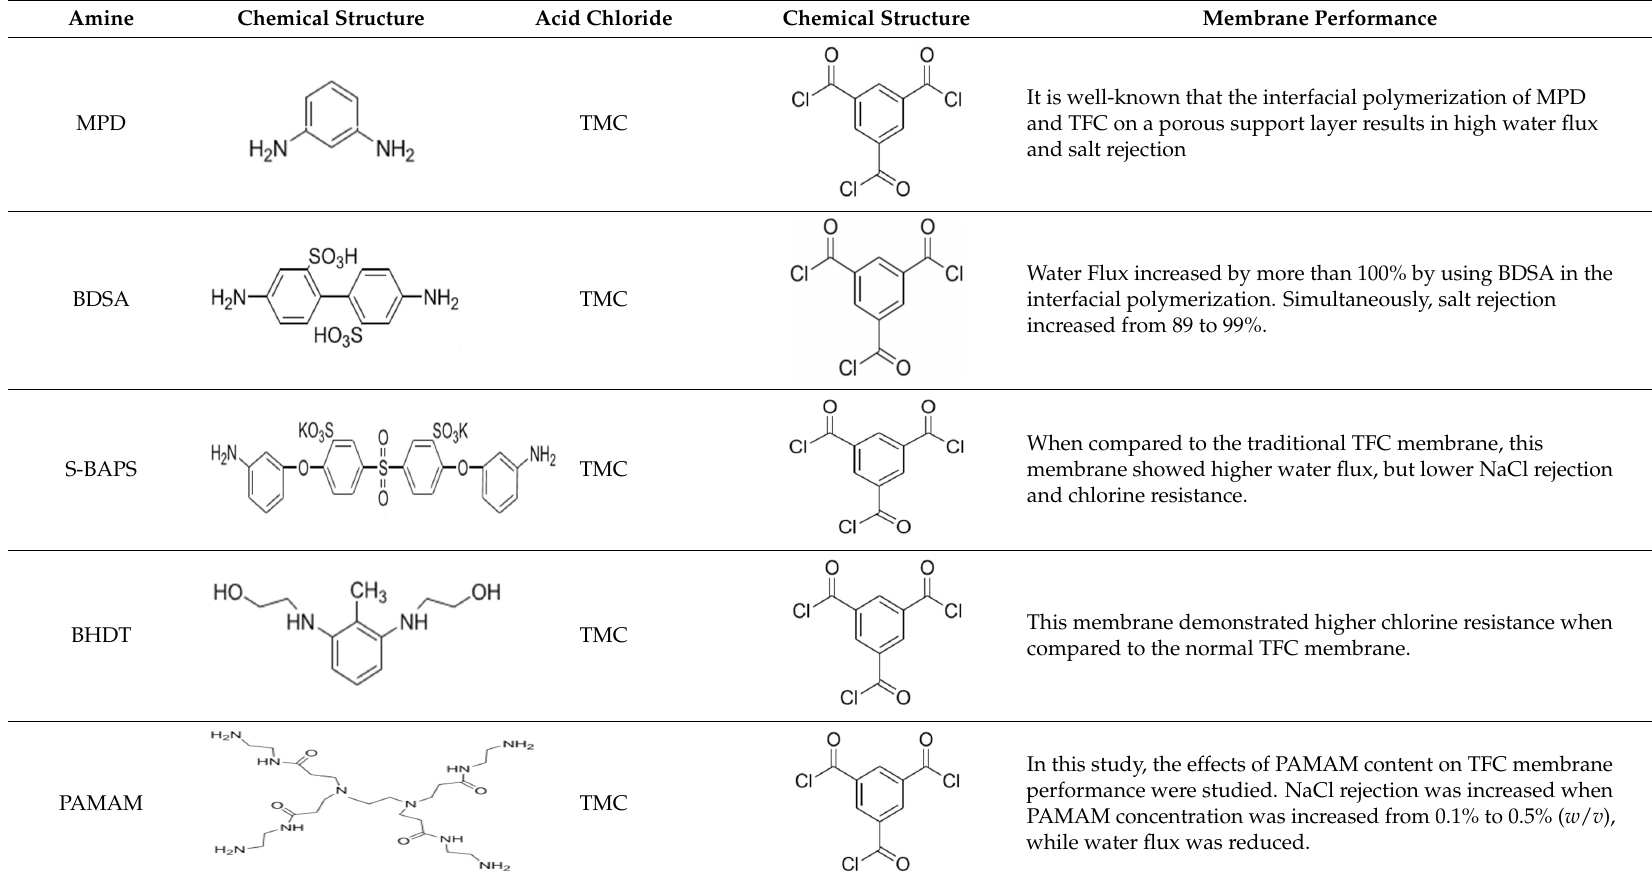
Table 1. Reported monomers for synthesis of polyamide composite membranes.